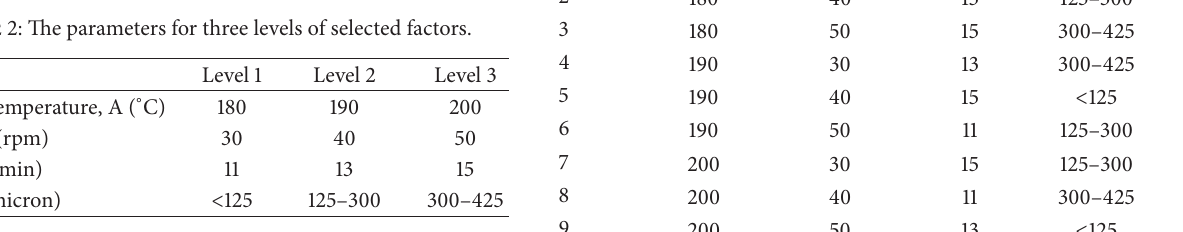
Table 3: L9 orthogonal array. Trail no.